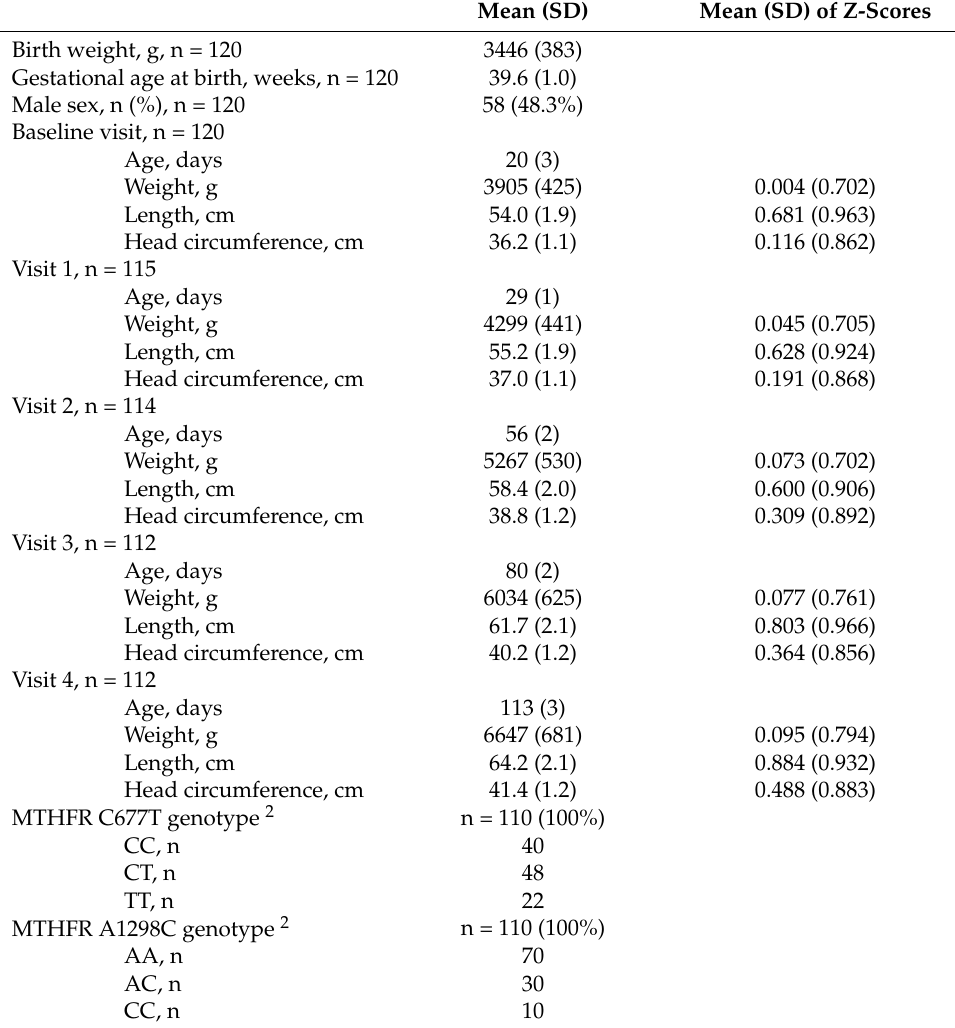
Table 1. Characteristics and anthropometric measures 1 of the breastfed